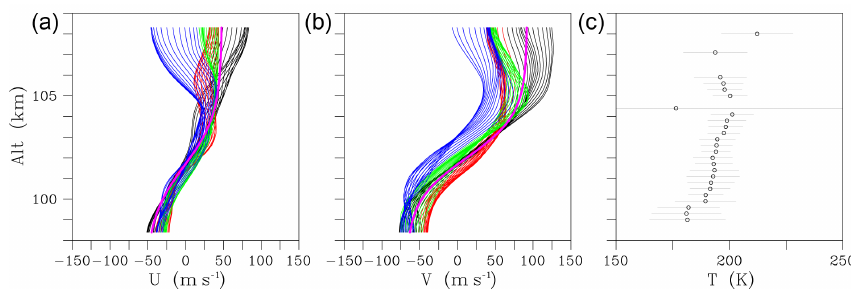
Figure 5. State-parameter estimates within the sporadic E layer patch seen between 20:12 and 21:15LT. Left: zonal winds. Middle: merid- ional winds. Right: temperatures. The change in color, from black to red to green to blue, indicates the passage of time. The violet curves are models reflecting conditions at 20:24LT used in subsequent analysis.